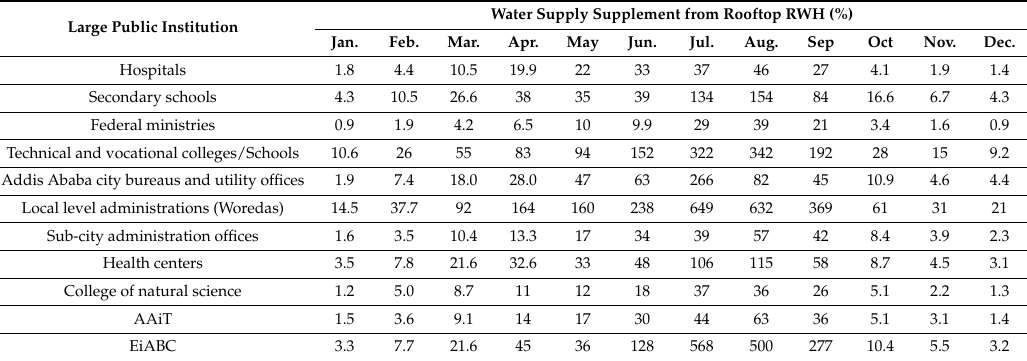
Table 5. Water supplement of large public institutions in Addis Ababa due to potential rooftop RWH from their rooftops.